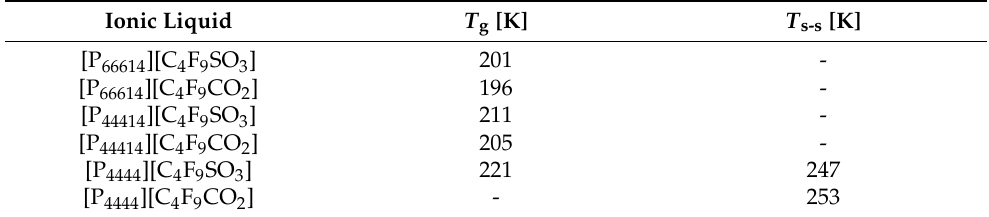
Table 2. Glass transitions ( T g ) and solid-solid transitions ( T s-s ) of the fluorinated ionic liquids.